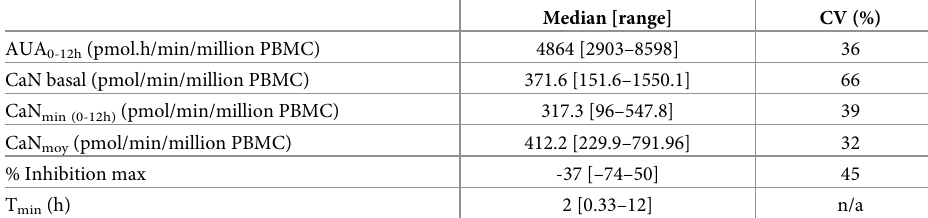
Table 4. Pharmacodynamic parameters (n =